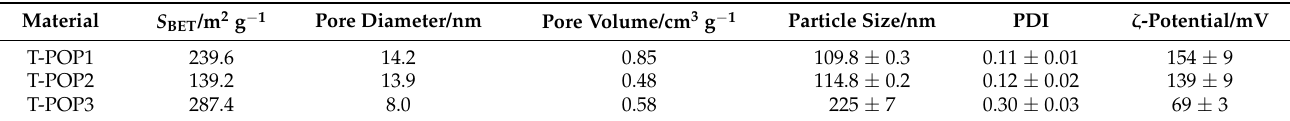
Table 1. Parameters obtained by N 2 sorption, DLS, and ζ -potential